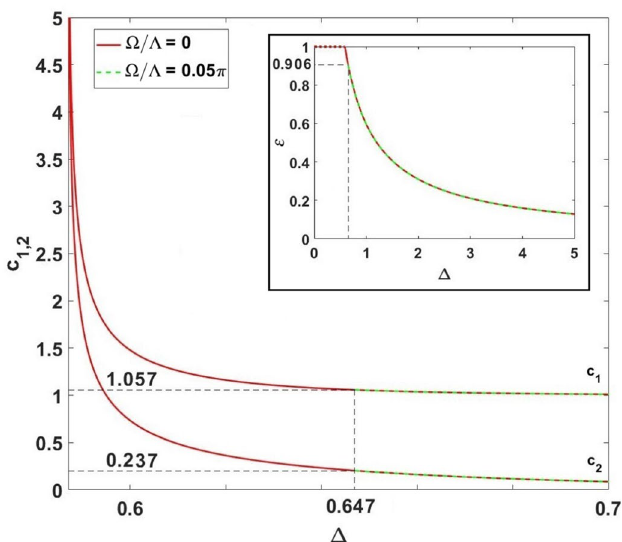
10 and different �/� . The = 0.647 corresponds to the intersoliton distance of the = 0.05 π , which is crucial for the SC-state =